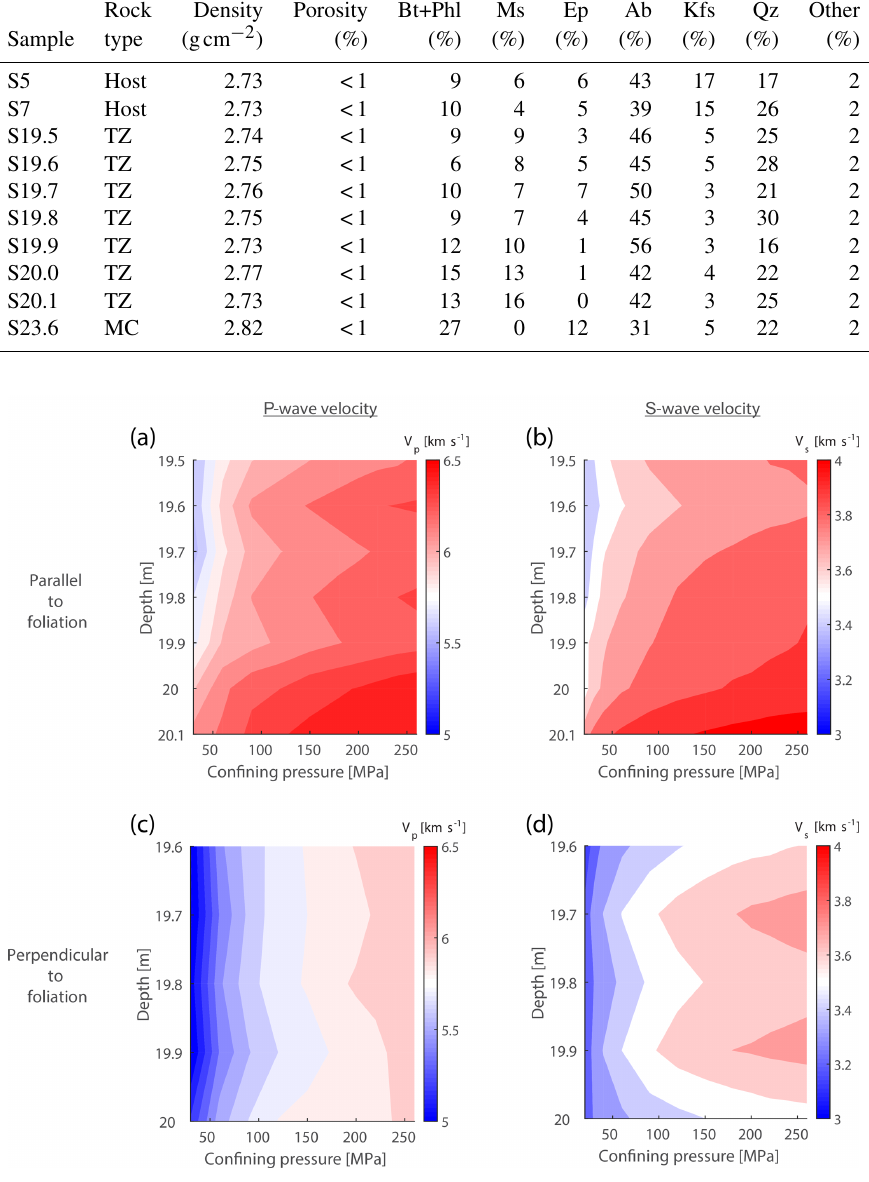
Figure 4. (a) and (b) display the results for foliation parallel velocities ( x 1 ) separated into V p (a) and V s (b) . (c) and (d) display the results for foliation perpendicular velocities ( x 3 ) separated into V p (c) and V s (d) . For V p and V s red colors indicate faster velocities and blue colors depict slower velocities (magnitude defined on the color